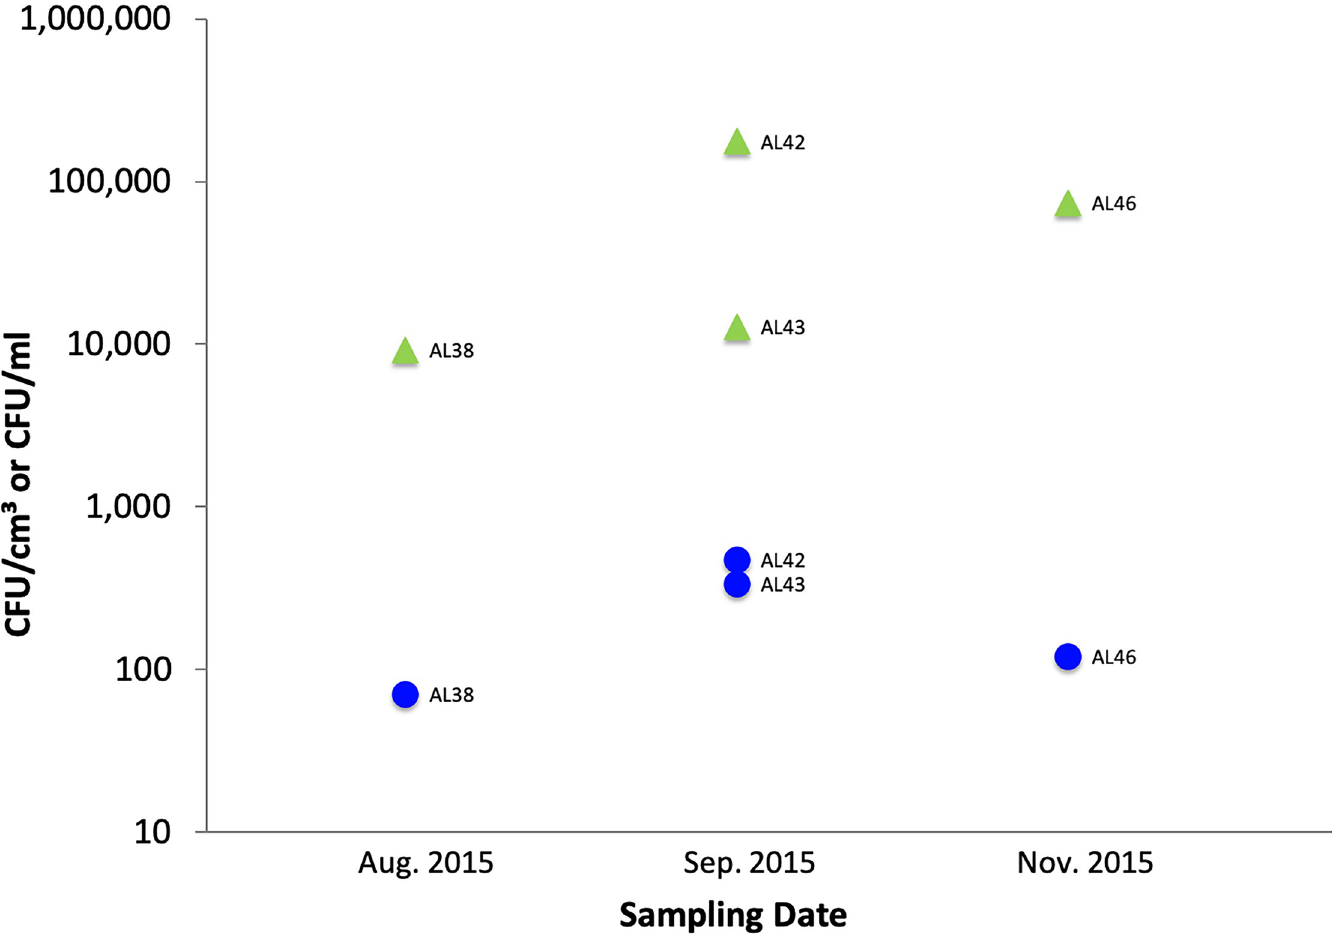
Fig 2. Concentrations of putative Vibrio spp. on PE (environmental samples; green triangles) and in paired water samples (filled blue circles).